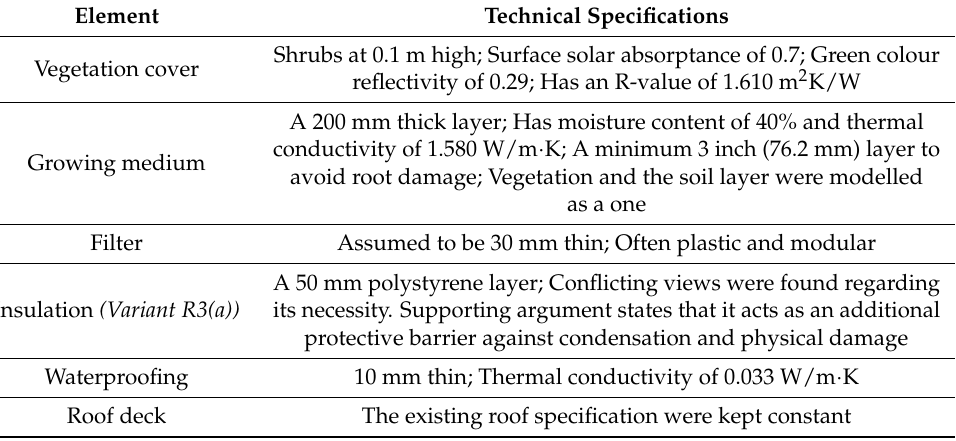
Table 9. Tested green roof specifications [51,52]: